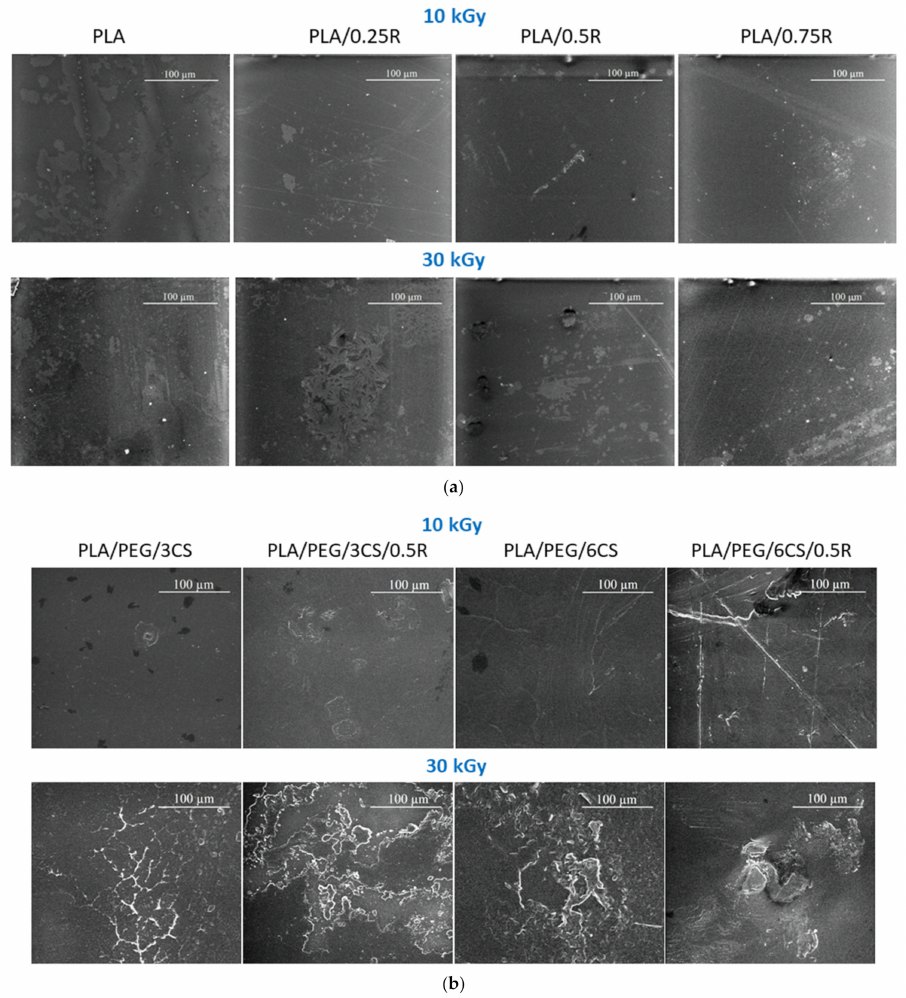
Figure 1. SEM pictures of the surface of the PLA and PLA/R blends ( a ), and of PLA/PEG/CS and PLA/PEG/CS/R biocomposites ( b ) at various gamma irradiation doses; magnification 1000 × , scale—100 µ